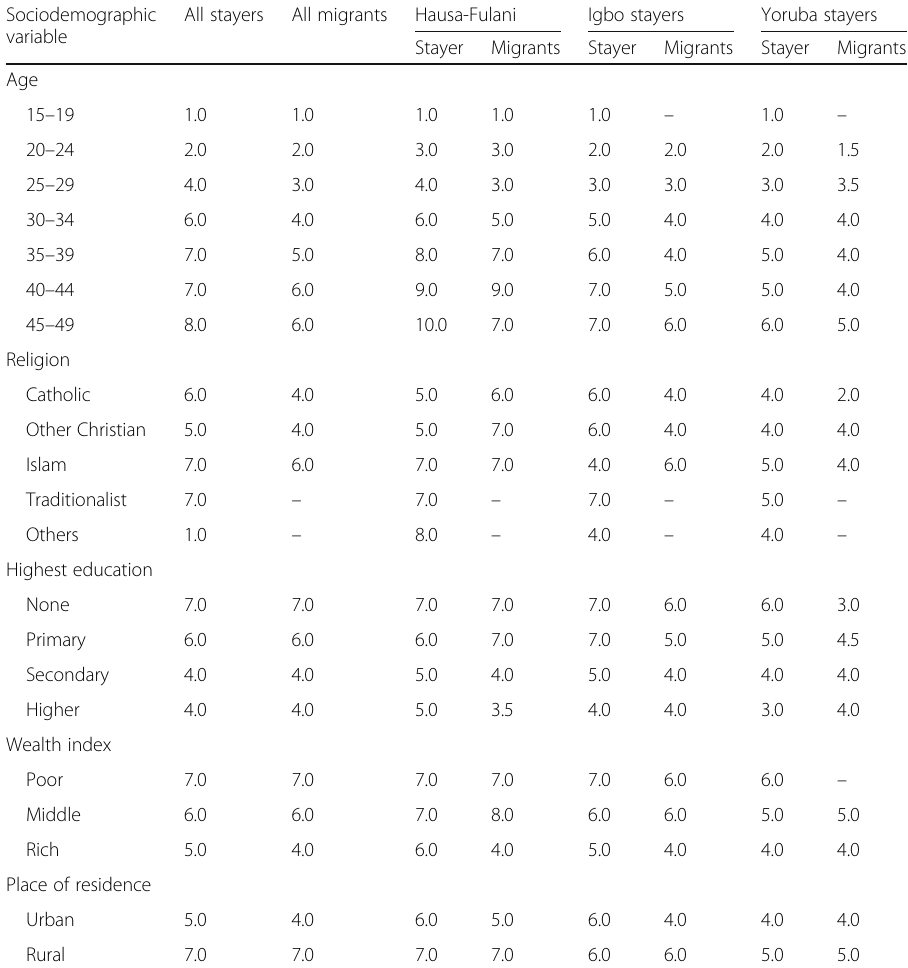
Table 3 Sociodemographic dimensions of children ever born (stayers and migrants) Sociodemographic All variable